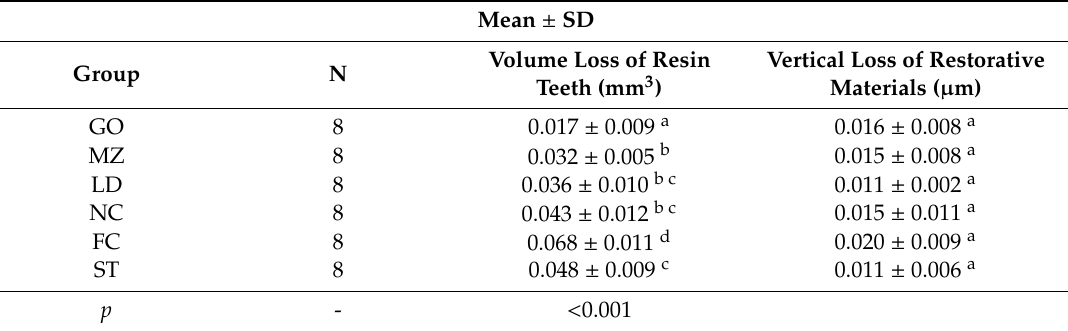
Table 2. Mean values and standard deviations of volume losses (mm 3 ) of resin teeth and vertical substance losses (unit: μm) of opposing restorative materials.